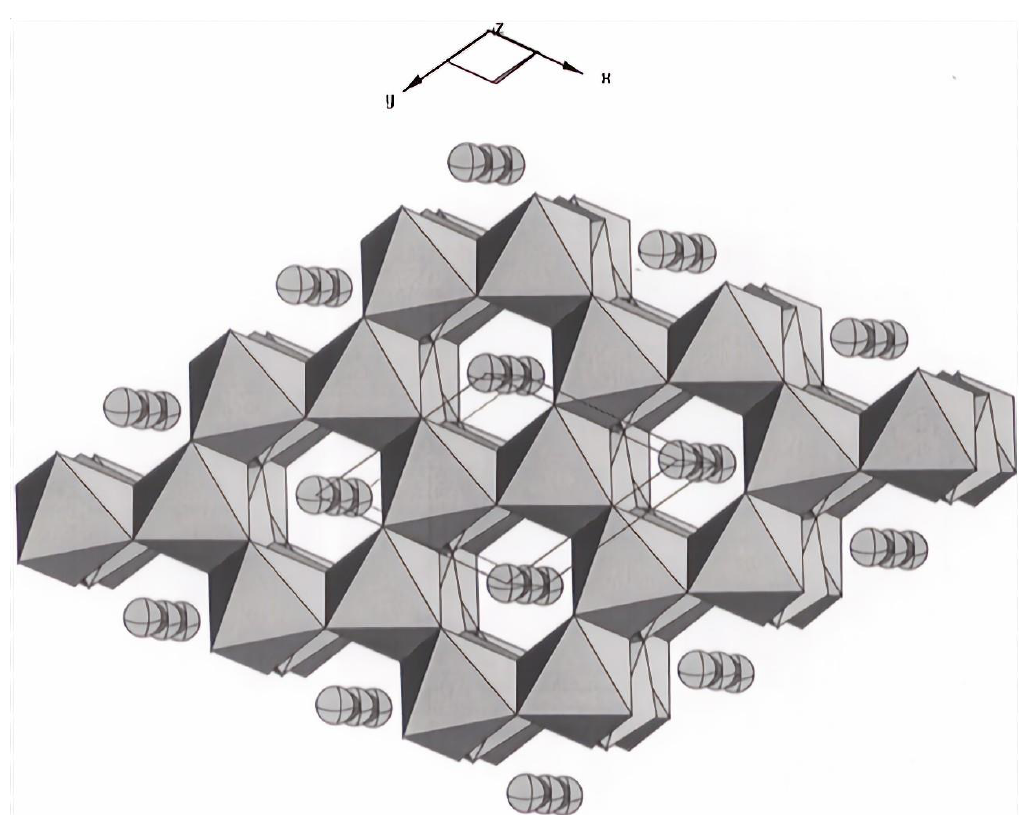
Figure 11. Schematic of an Al(OH) 3 layer, showing octahedral holes that allow lithium to enter [108]. Reprinted with permission from Besserguenev, A.; Fogg, A.; Francis, R.; Price, S.; O'hare, D.; Isupov, V.; Tolochko, B. Synthesis and Structure of the Gibbsite Intercalation Compounds [LiAl 2 (OH) 6 ] X (X = Cl, Br, NO 3 ) and [LiAl 2 (OH) 6 ] Cl-H 2 O Using Synchrotron X-ray and Neutron Powder Diffraction. Chem Mater 1997, 9, 241–247. Copyright 1997 American Chemical Society.